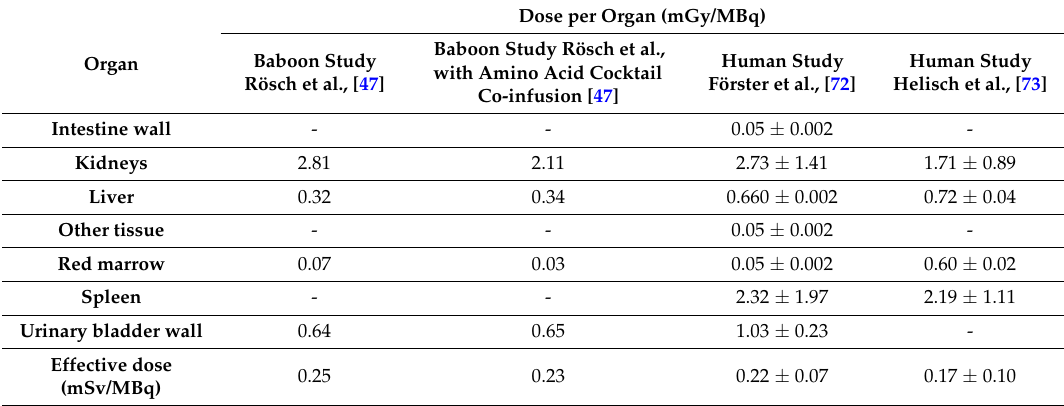
Table 4. Anticipated radiation doses due to the use of 90 Y-DOTATOC in humans and derived from PET studies with 86 Y-DOTATOC in baboons and